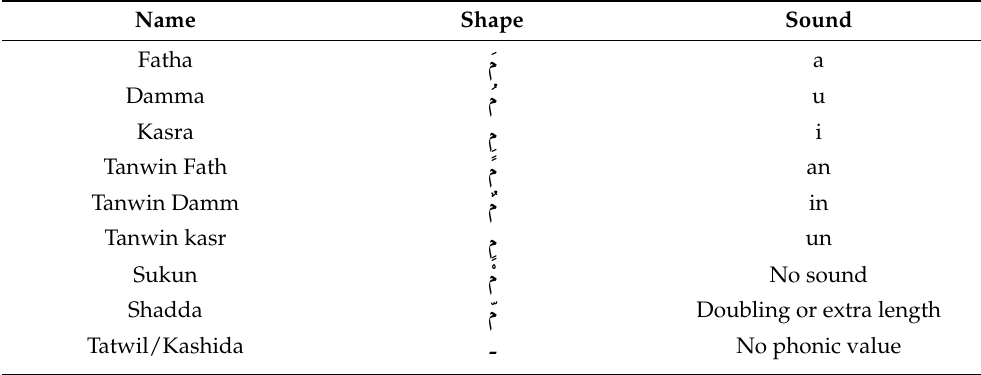
Table 2. Information on the main Arabic diacritics (diacritic name, shape on the letter "م" , and sound).